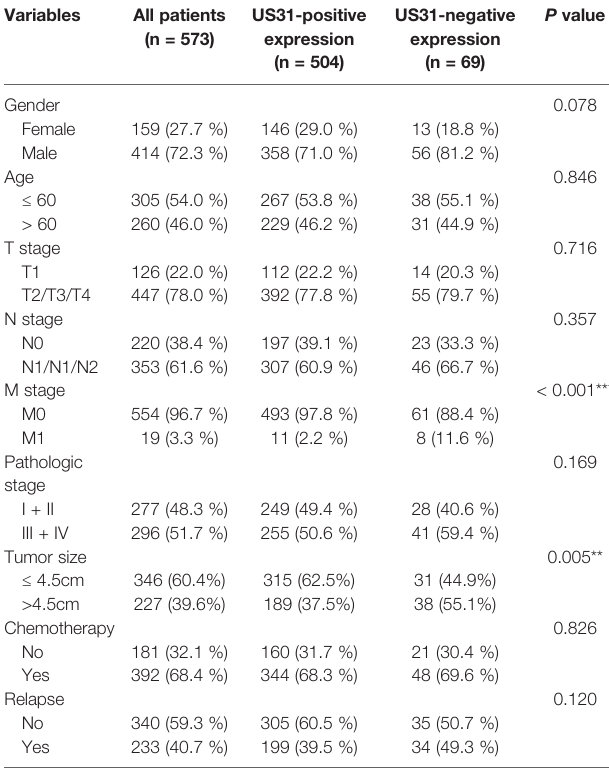
TABLE 2 | Clinicopathological characteristics of gastric cancer patients and their correlation with the expression of HCMV US31 protein.